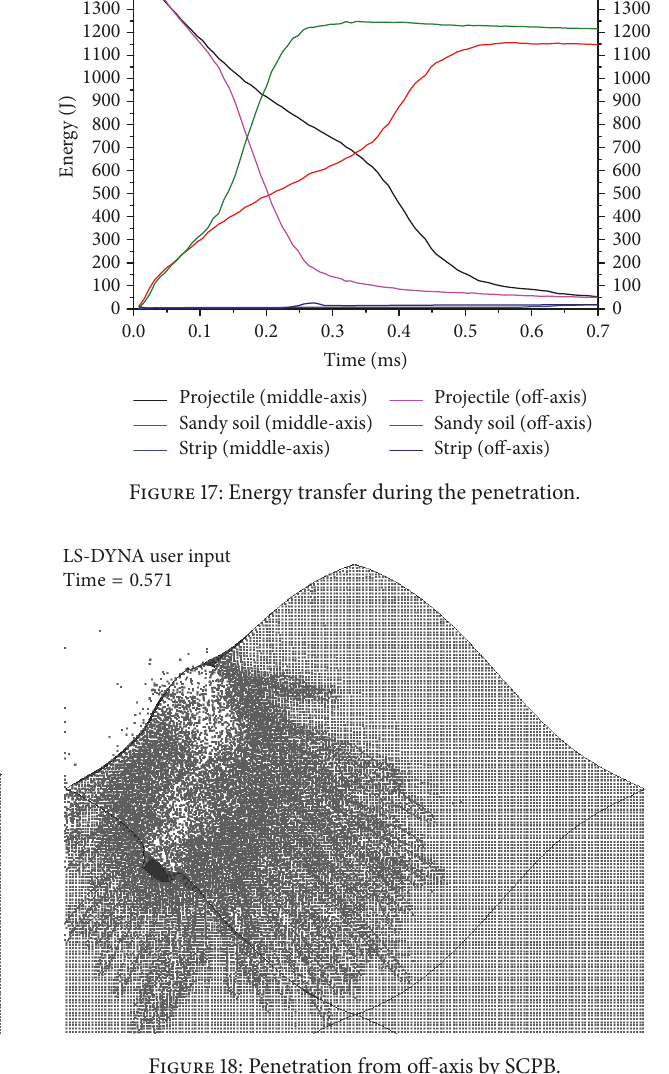
Figure 18: Penetration from off-axis by